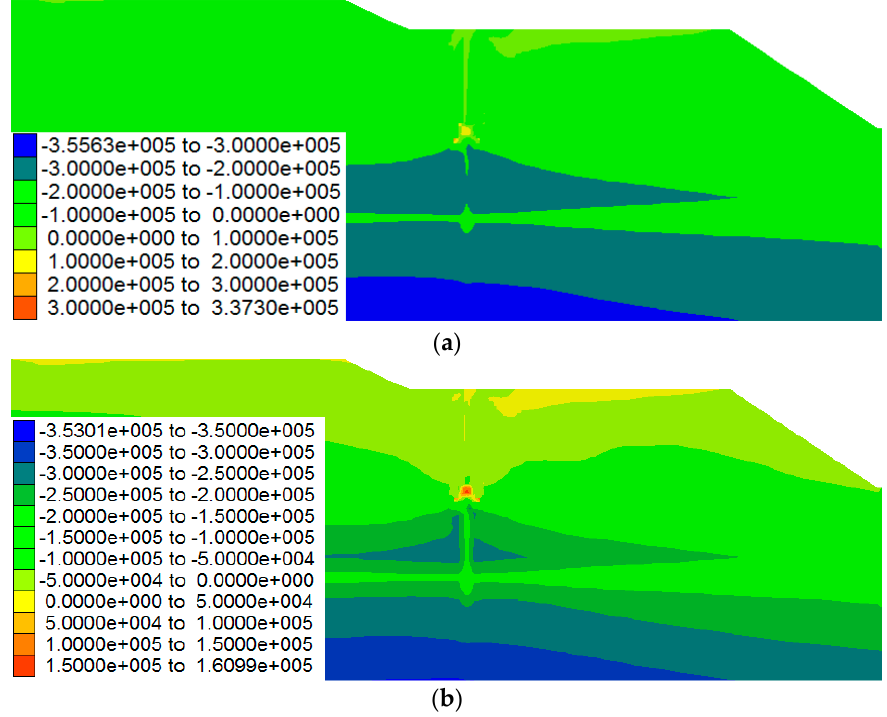
Figure 17. Comparison of minimum principal stress of monitoring surface. ( a ) 1. ( b ) 2.